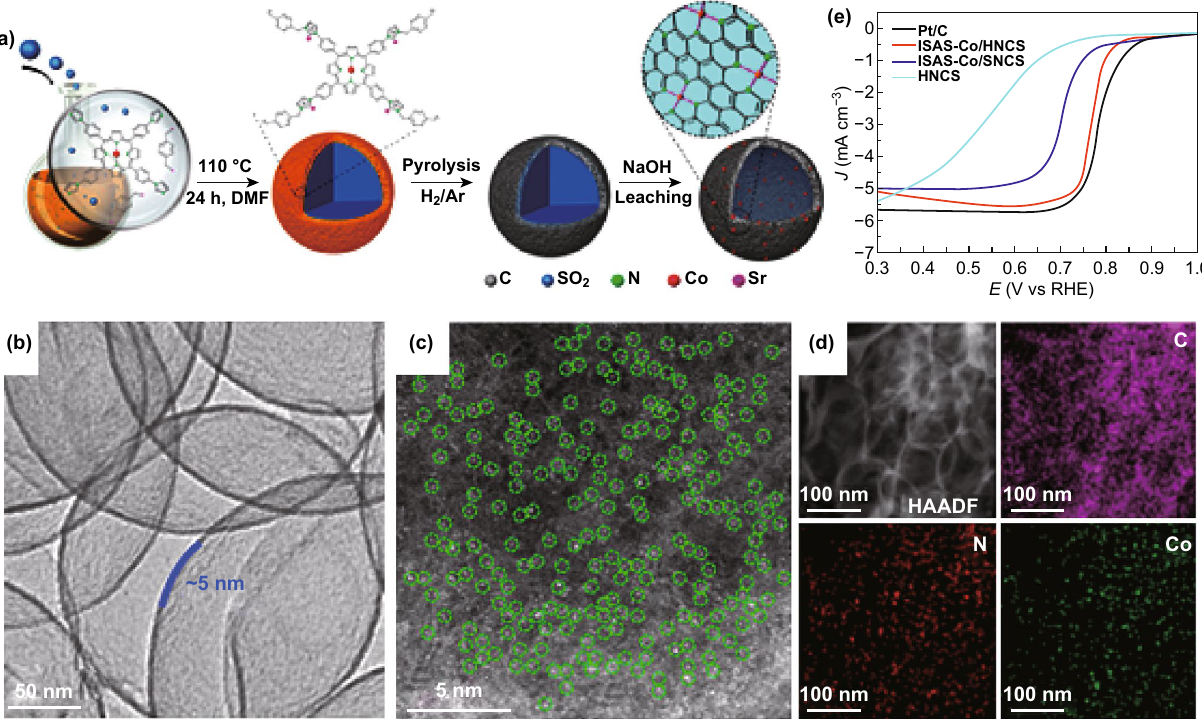
Fig. 4 a The synthetic process of ISAS-Co/HNCS. b TEM and c AC-HAADF-STEM images of ISAS-Co/HNCS. d HAADF-STEM image and corresponding EDX element mapping of ISAS-Co/HNCS. e ORR polarization curves. a – e Reproduced from Ref. [107] with permission. Copy- right 2017 American Chemical